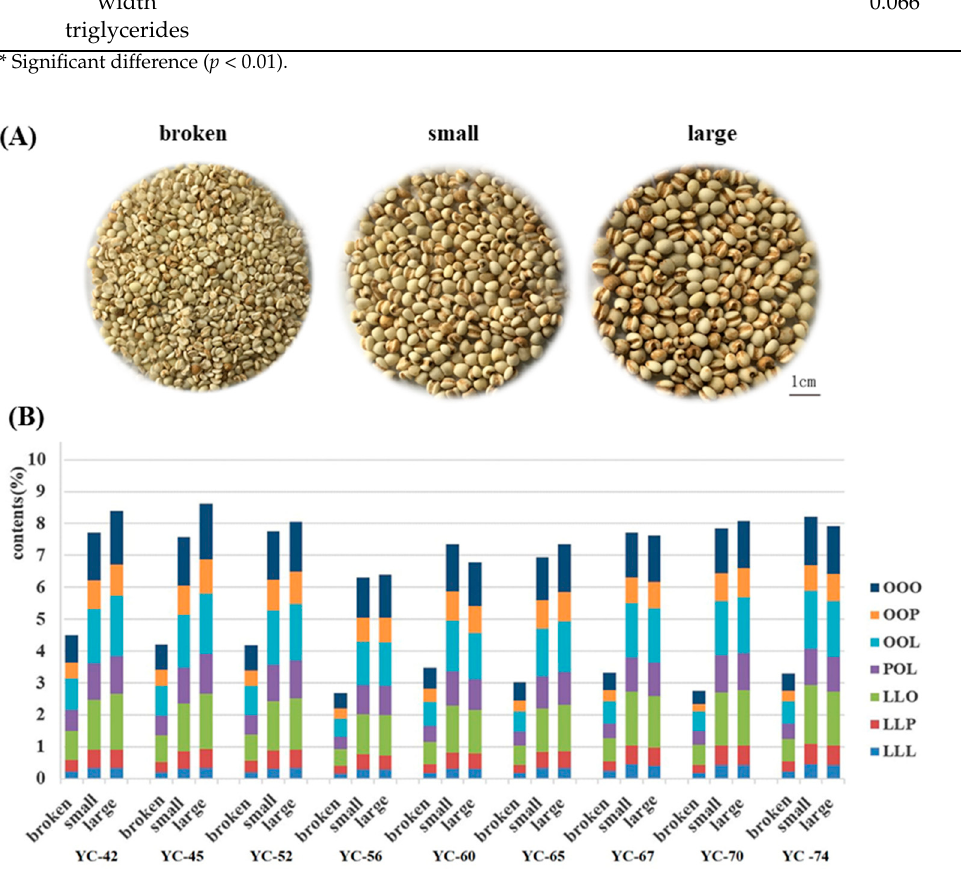
Figure 3. The optical graphs ( A ) and the content of TAGs ( B ) from the broken grain, small grain (width < 4.5 mm) and large grain (width > 5.5 mm).